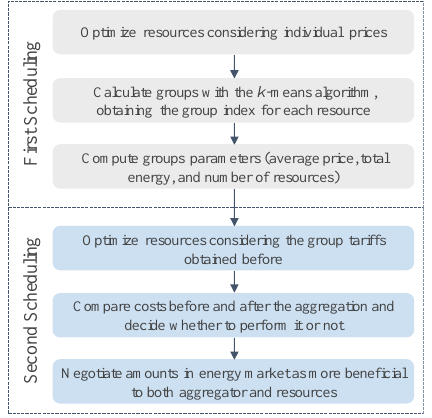
Figure 1. Proposed methodology scheme.